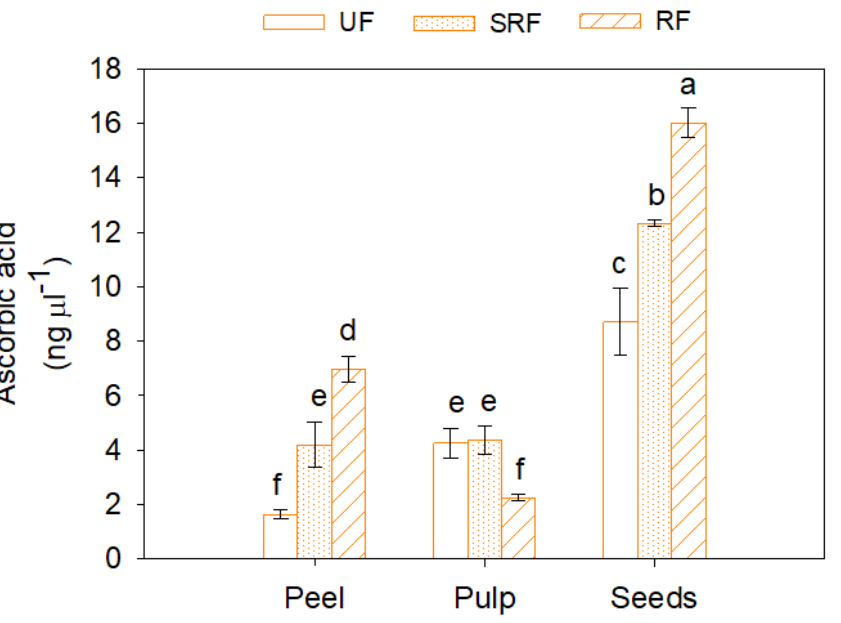
Figure 2. Ascorbic acid content in peel, pulp, and seeds of unripe (UF), semi-ripe (SRF) and ripe fruits (RF), of Phlegrean mandarin. Each bar represents the mean ± SE ( n = 8). Different letters indicate significant differences ( p < 0.05), according to Duncan’s post-hoc test. FW: fresh weight.